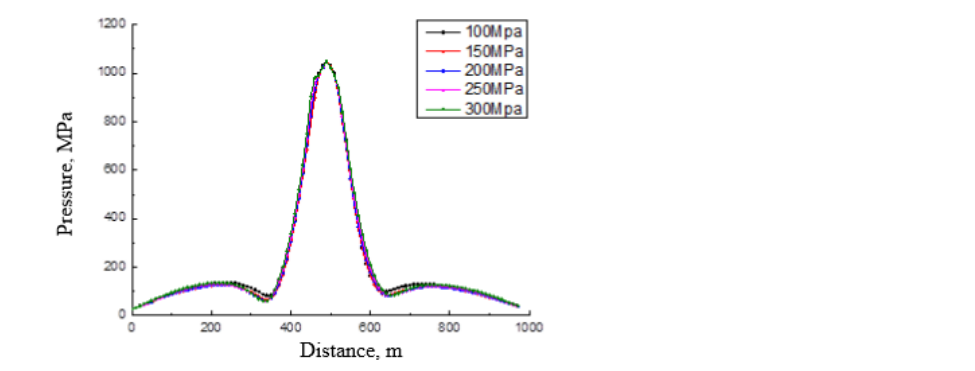
Figure 24. Variation curve of casing stress along the axial direction of different rock compressive strengths when the slip is 10 mm.